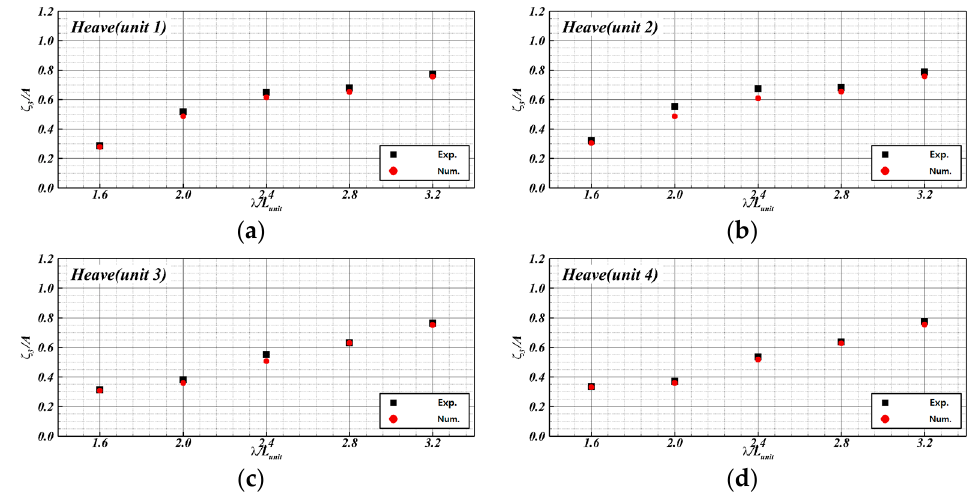
Figure 16. Heave RAOs for 𝑯/𝝀 = 0.03 under head sea: ( a ) Unit 1; ( b ) Unit 2; ( c ) Unit 3; ( d ) Unit 4.